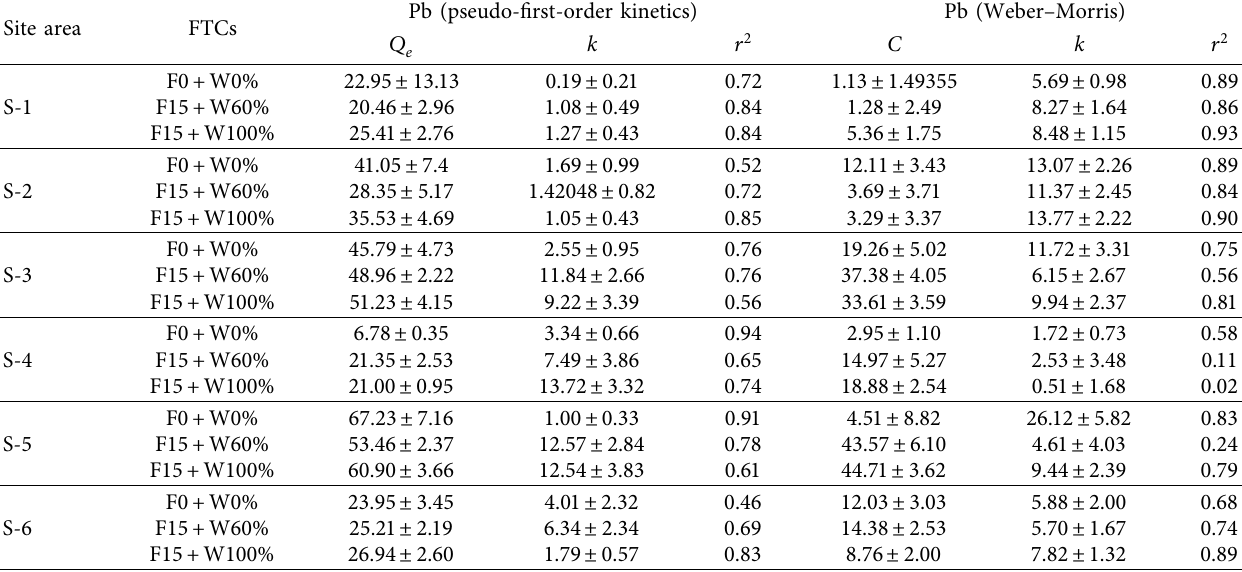
Table 3: Pseudo-first-order and Weber–Morris parameters of Pb in soils under different freeze-thaw conditions.